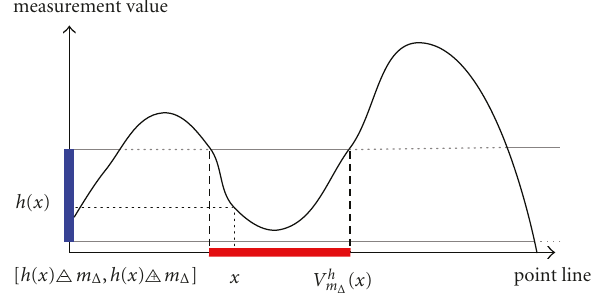
Figure 1: One-dimensional computation of a general adaptive ( x ) using the LIP framework. For a point x , a neighborhood set V h m (cid:3) is first computed around h ( x ). Secondly, the range of tolerance m (cid:0) inverse map of this interval gives a subset of the 1D spatial